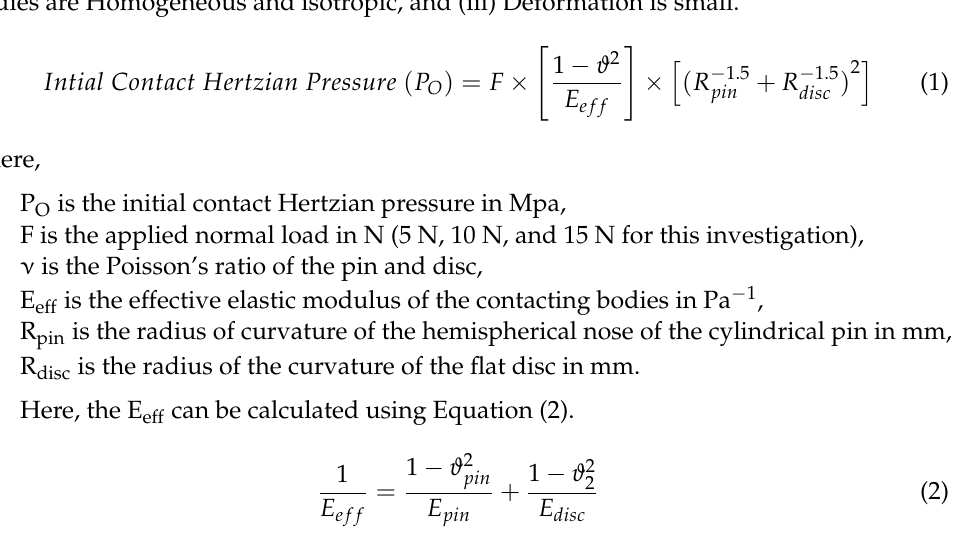
Table 4. Mechanical properties of rail [33].